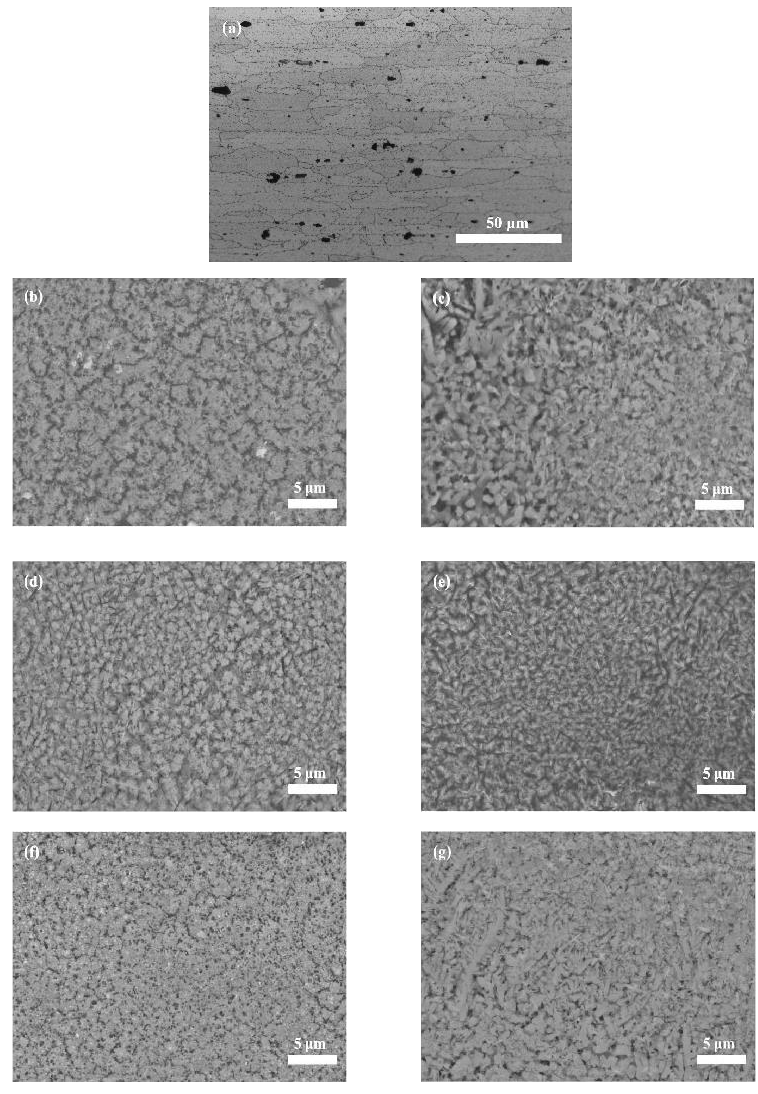
Figure 7. SEM microstructure at regions A and B of the biomimetic samples with different spacing: